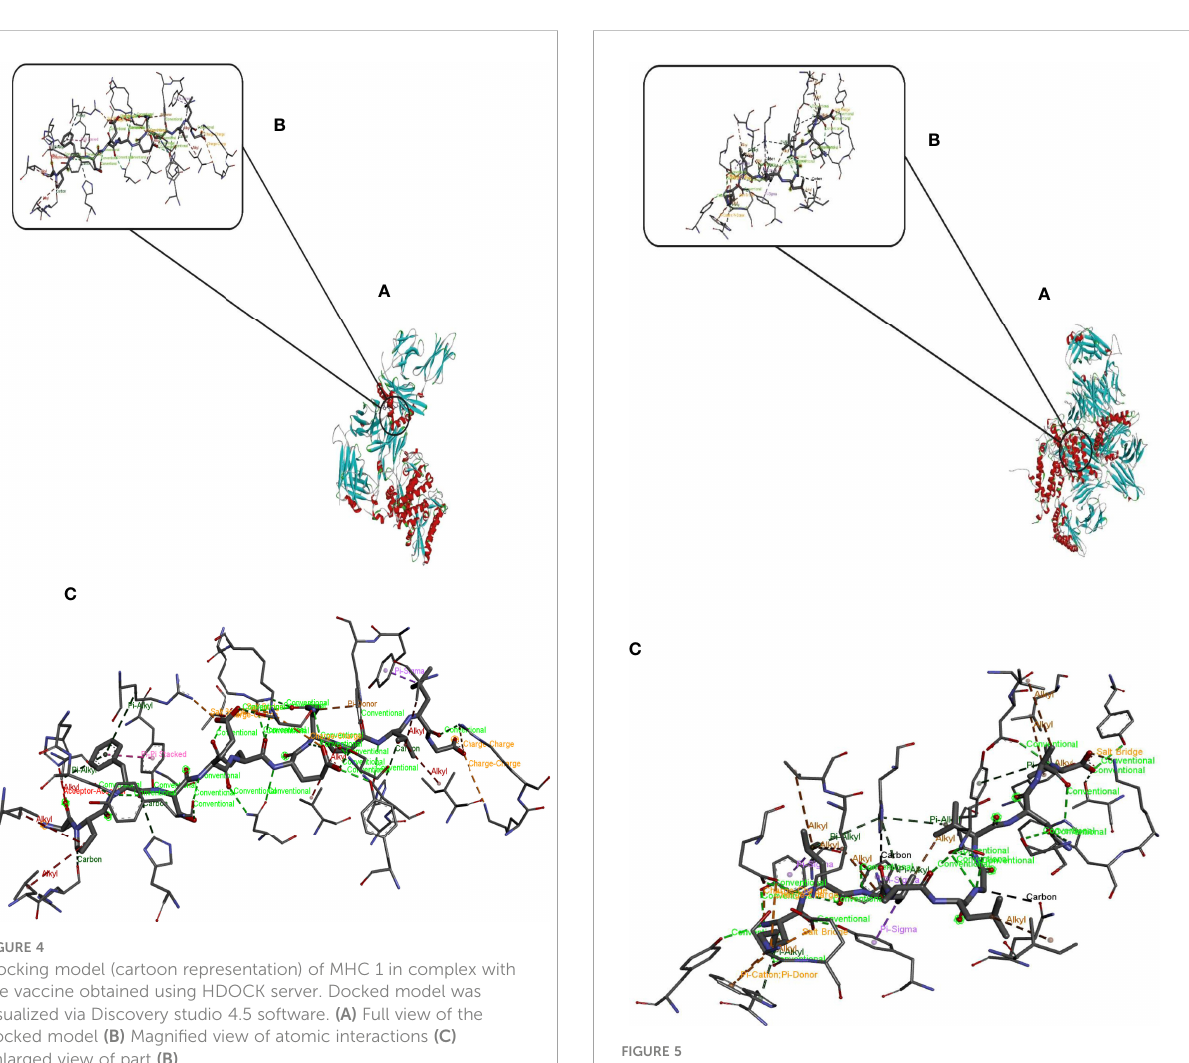
Docking model (cartoon representation) of MHC 2 in complex with the vaccine obtained using HDOCK server. Docked model was visualized via Discovery studio 4.5 software. (A) Full view of the docked model (B) Magni fi ed view of atomic interactions (C) Enlarged view of part (B)